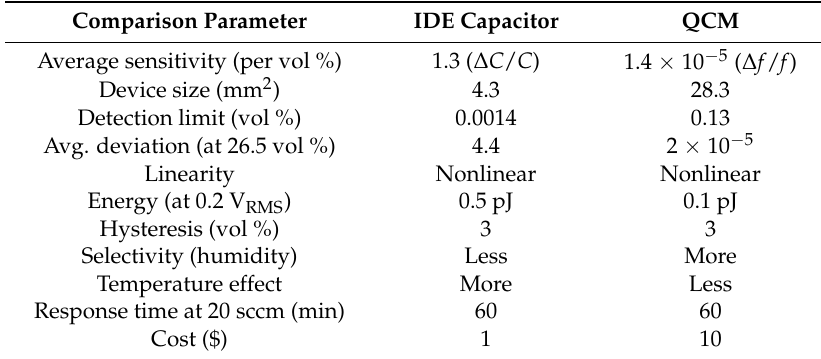
Table 2. Overview of the comparison of IDE- and QCM-based sensors.